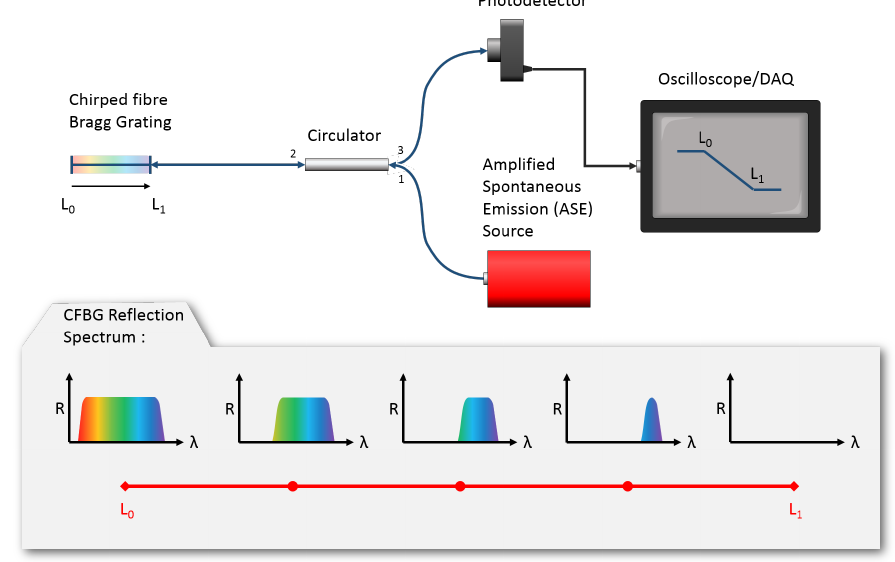
Figure 1. Schematic showing the interrogation setup for CFBG velocity probes. A broad bandwidth ASE source illuminates a chirped grating. The reflected signal-power is monitored on a